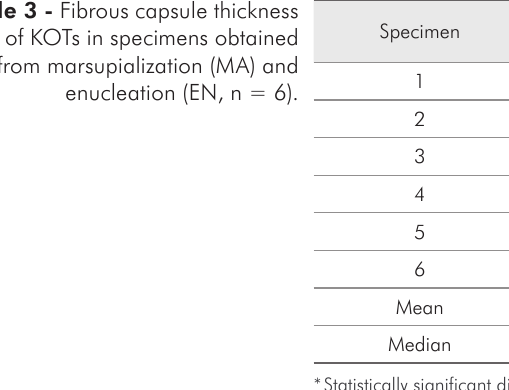
Table 3 - Fibrous capsule thickness of KOTs in specimens obtained from marsupialization (MA) and enucleation (EN, n =